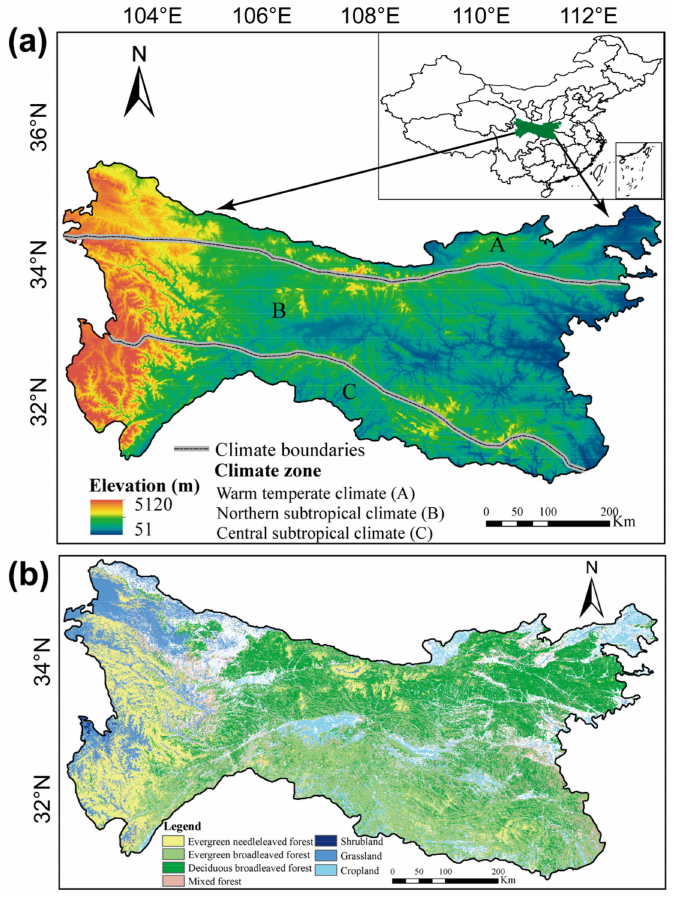
Figure 1. An overview of ( a ) the study area and ( b ) spatial distribution of vegetation types. Only pixels with unchanged vegetation types were analyzed in this study period. The dataset with a total of 218,899 pixels was divided into seven vegetation